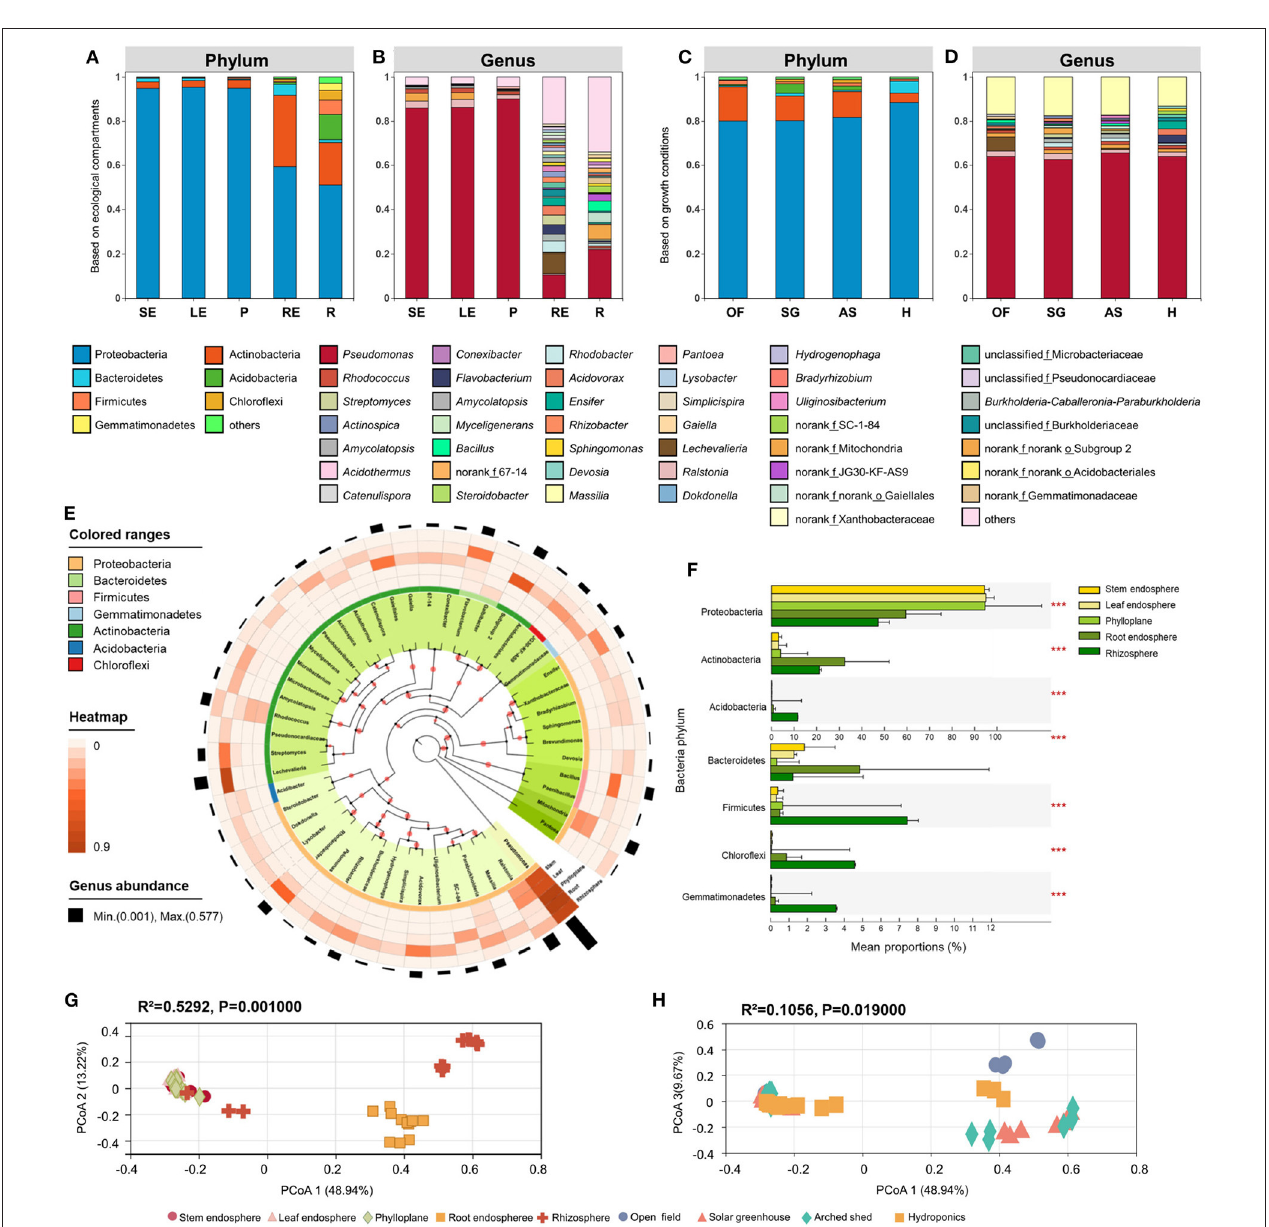
FIGURE 2 | Bacterial community composition in different ecological compartments and growth conditions. The bacterial composition at the phylum (A) and genus (B) levels in different ecological compartments. SE, stem endosphere; LE, leaf endosphere; P, phylloplane; RE, root endosphere; R, rhizosphere. The bacterial composition at phylum (C) and genus (D) levels in different growth conditions. OF, open field; SG, solar greenhouse; AS, arched shed; H, hydroponics. (E) Bacterial phylogenetic tree. We selected the top 50 bacteria with relative abundance to construct the system tree. Visualization was performed on the iTOL website (https://itol. embl.de/). The colors in the inner circle represents the specific bacterial phyla. Four outer circles represent four different groups, and the height shows the abundance of genera. (F) Significant differences in bacterial phyla among different growth conditions. Bacterial beta diversity PCoA based on Bray-Curtis distance in ecological compartments, (G) and different growth conditions, (H) . * P ≤ 0.05, ** P ≤ 0.01, *** P ≤